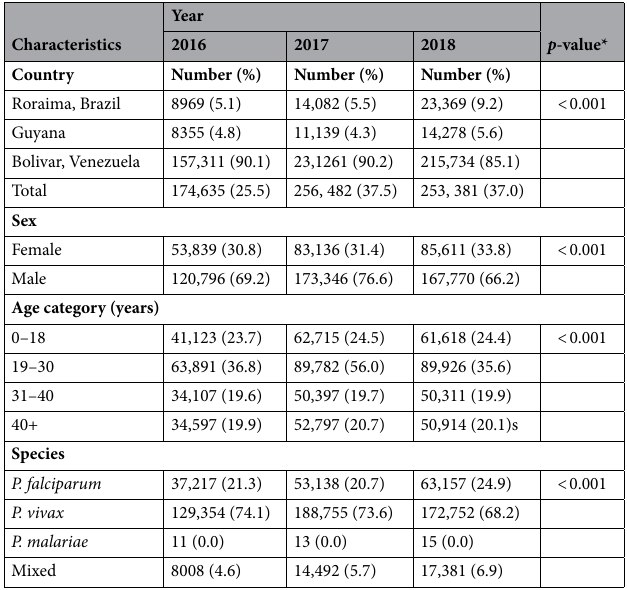
Table 1. Demographic characteristics of malaria from 2016 to 2018. * p -value significant at <